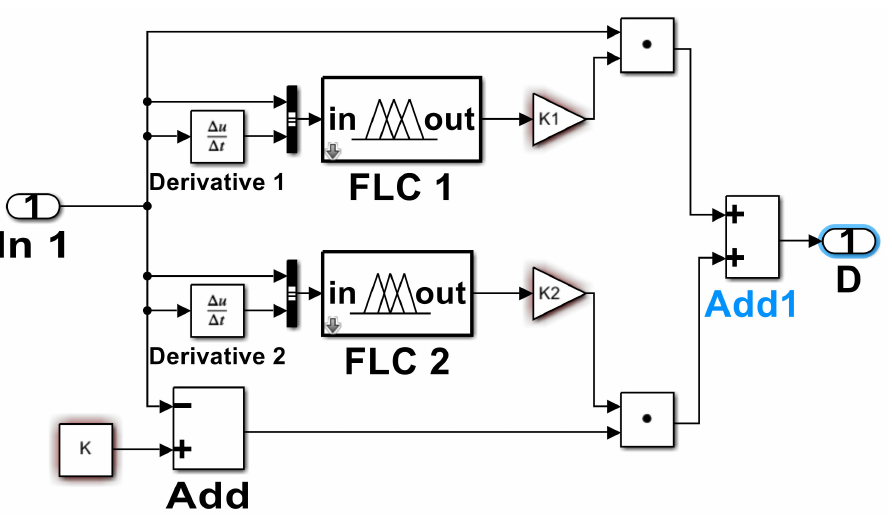
Figure 12. Construction of the